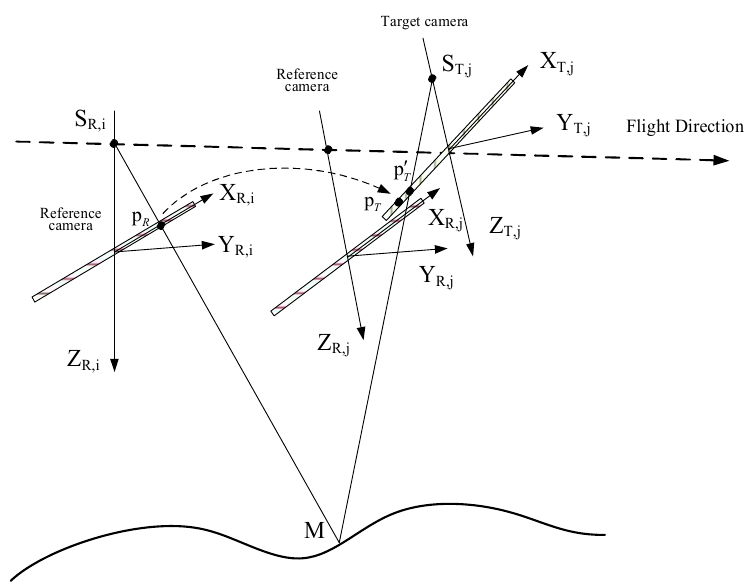
Figure 3. Relative orientation schematic diagram.